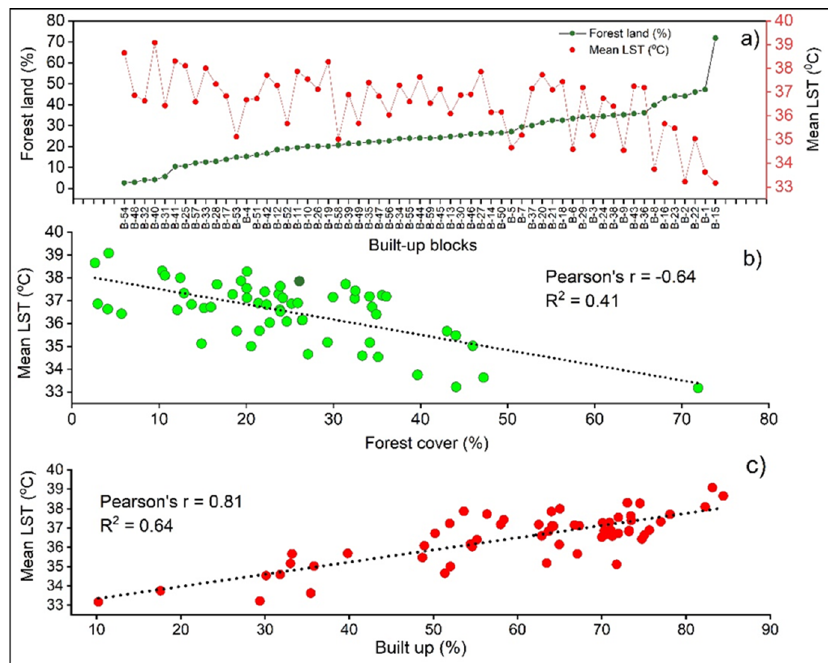
Figure 9. Relationship between forest and LST, ( a ) relationship between forest land (%) and LST, ( b ) regression analysis between forest and LST, ( c ) regression analysis between built-up and LST.